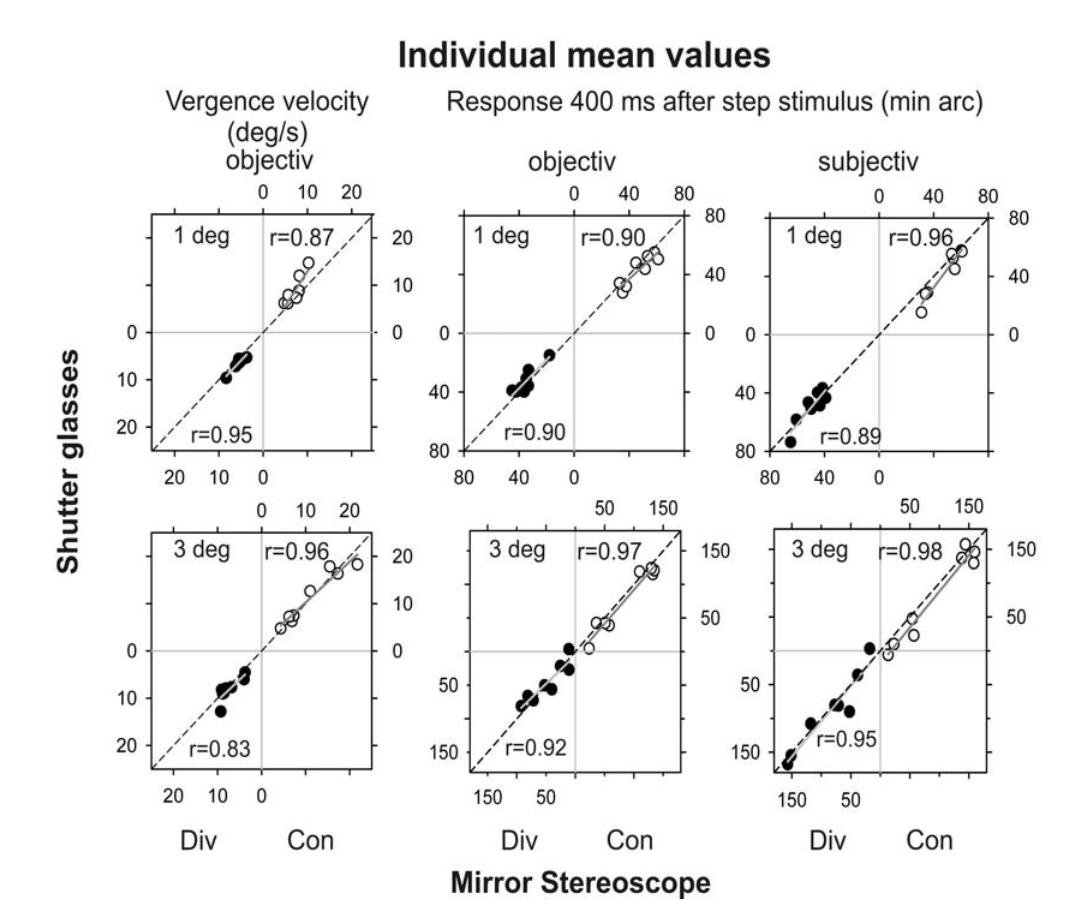
Figure 2. Each graph gives the comparison of shutter glasses and mirror stereoscope for the individual mean values of 8 subjects. The three dependent measures are the objectively measured maximal vergence velocity and the response reached at a moment in time 400 ms after the disparity step stimulus, measured objectively and subjectively (with nonius lines). Upper and lower graphs refer to the 1 deg and 3 deg disparity step stimulus. Convergent responses are shown by open symbols in the upper right quadrants, divergent re- sponses by closed symbols in the lower left quadrants.. Note that for each graph, regression lines and Pearson correlation coefficients are given separately for convergent and for divergent step responses. The identity line is shown as a reference.